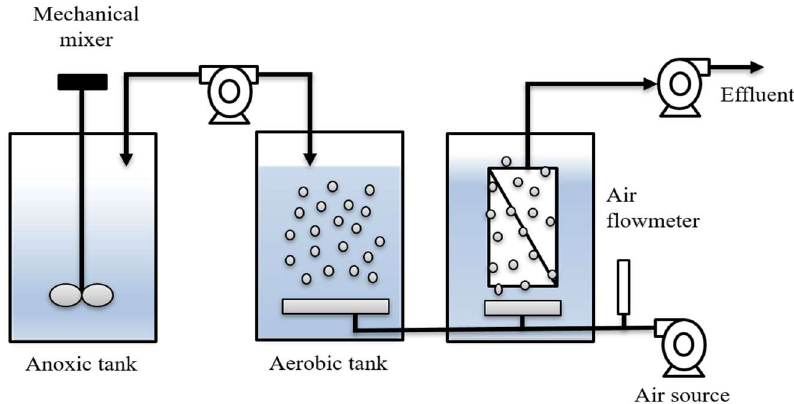
Figure 1. Schematic diagram of membrane bioreactor consisting of an anoxic tank, an aerobic tank and a separate membrane filtration tank. Recirculation of the MLSS (mixed liquor suspended solids) between the tanks ensured nitrification and denitrification at the two different redox potentials.